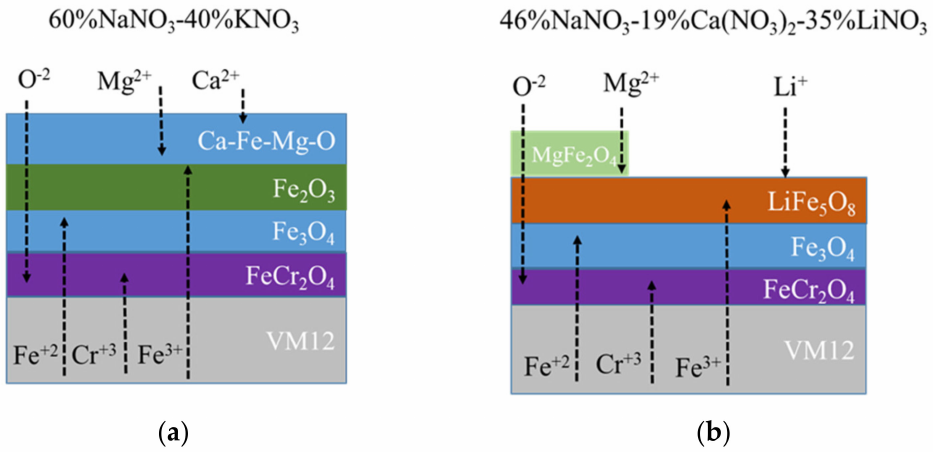
Figure 14. Sketches of oxide layers formed in the stainless steel after molten salt exposure; ( a ) Solar Salt, ( b ) 19% Ca (NO 3 ) 2 -46% NaNO 3 -35% LiNO 3